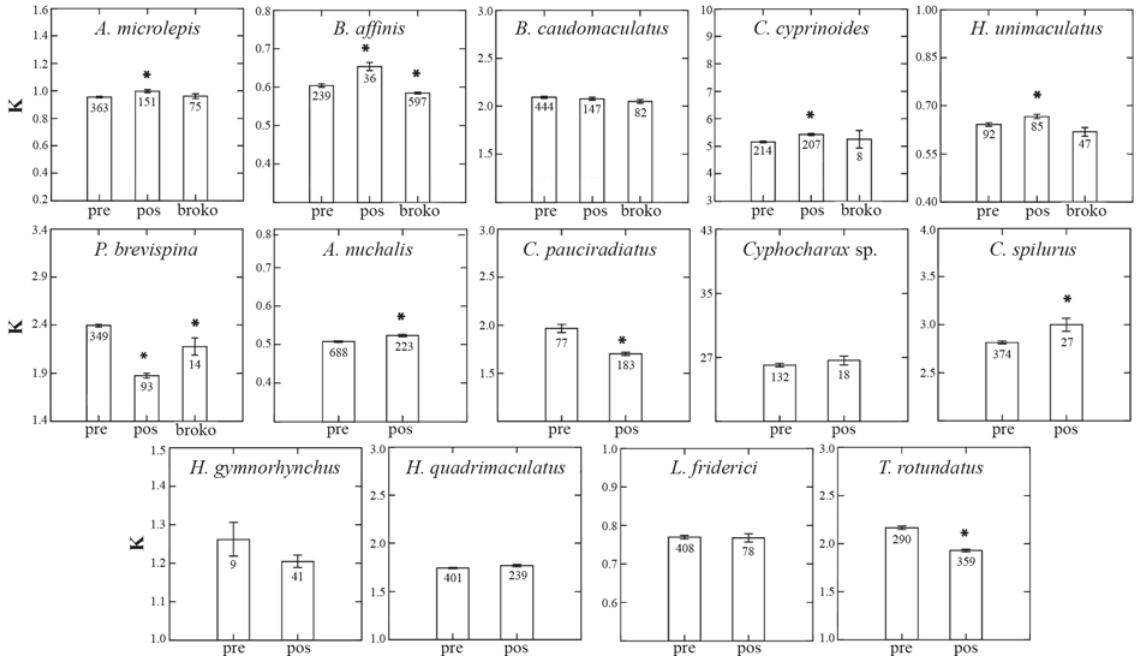
Fig. 3. Comparison of the condition factor of females of the 14 studied species in the different situations. pre = Sinnamary River 1994-1996, pos = Petit-Saut Reservoir 2002-2003, broko = Brokopondo Reservoir 2002-2003. Stars indicate significant differences with the Sinnamary River by t test. The number of specimens used for the comparison appears inside the